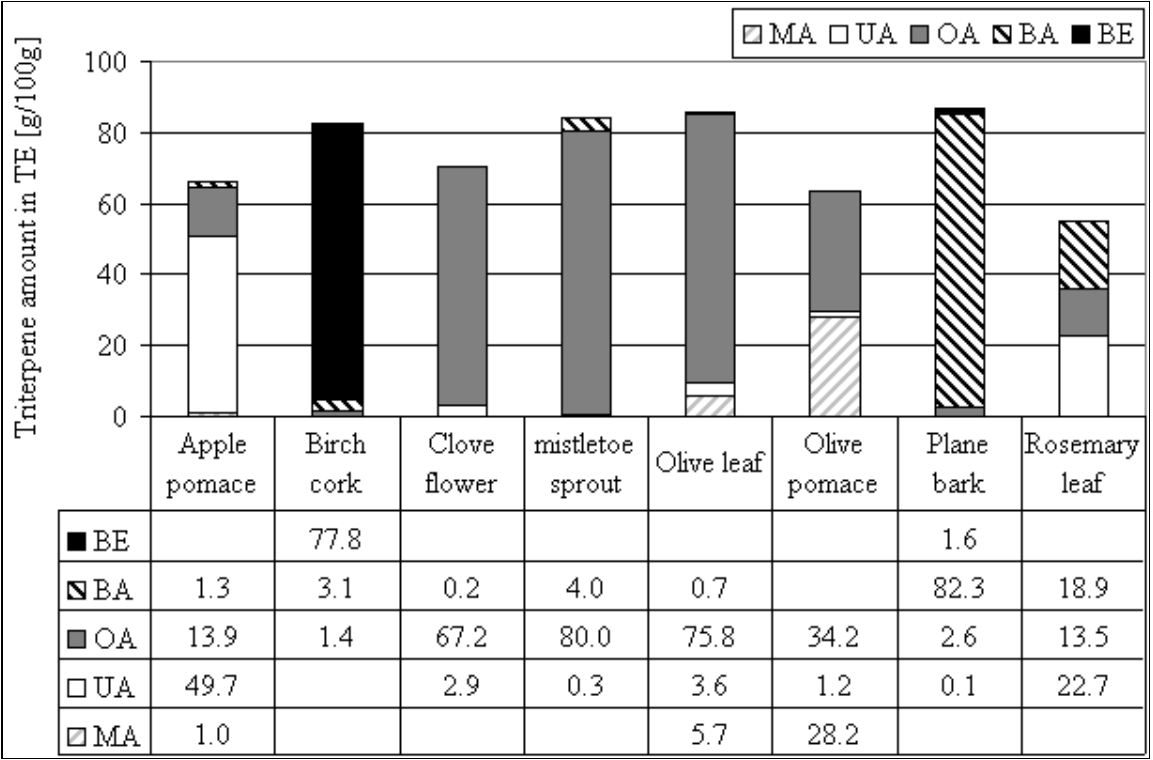
Figure 4. Triterpene amount within triterpene dry extracts (TE) from various plant